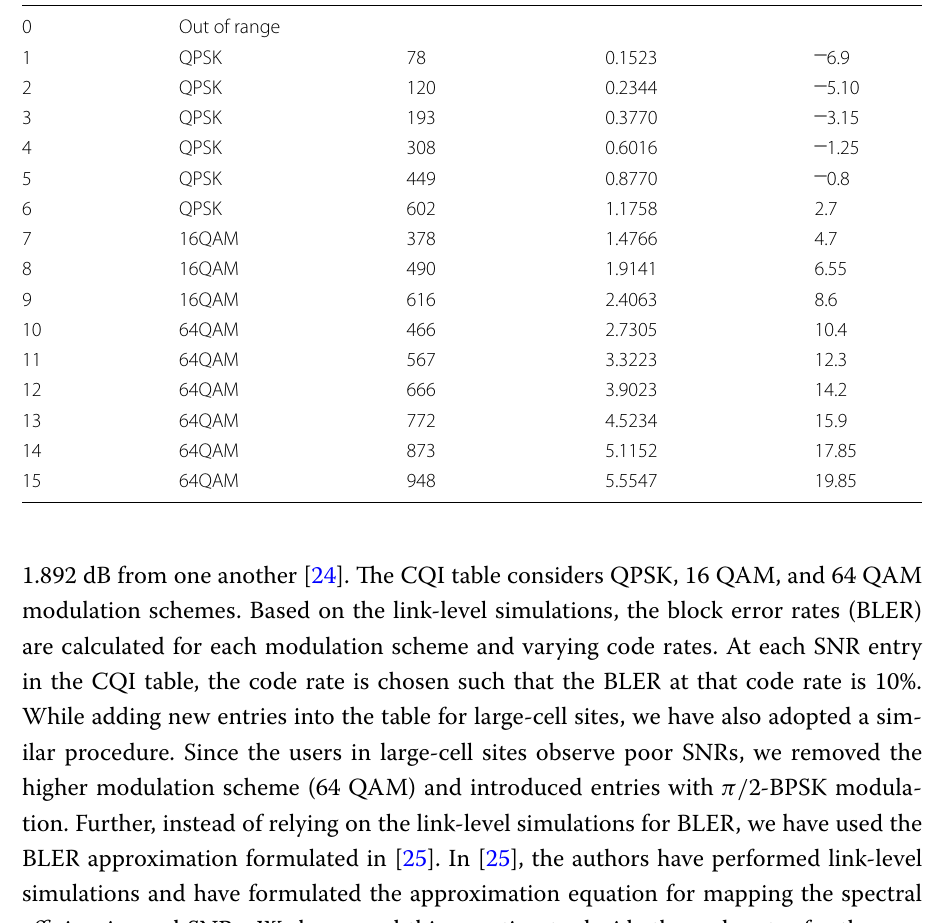
1024 Efficiency SNR in dB ×